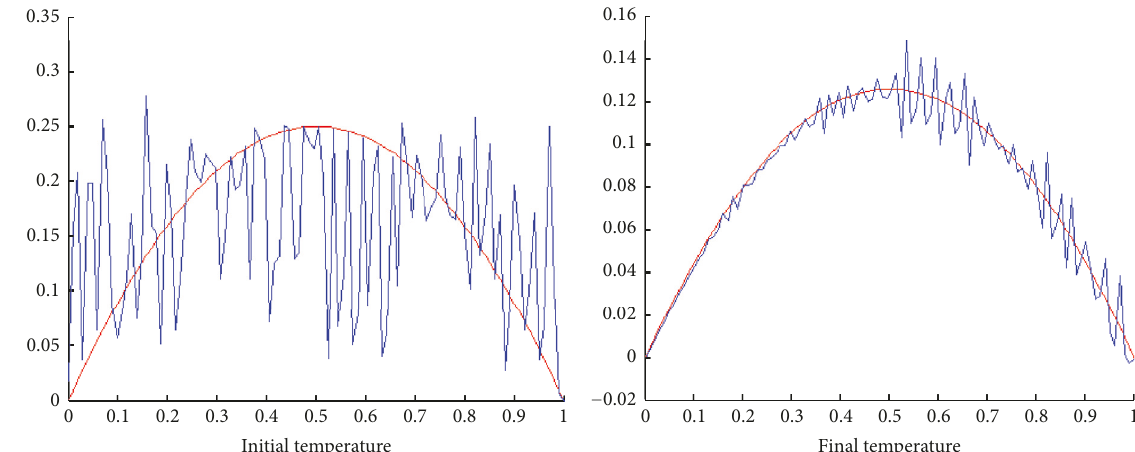
Figure 22: This figure shows that we cannot rebuild the solution.